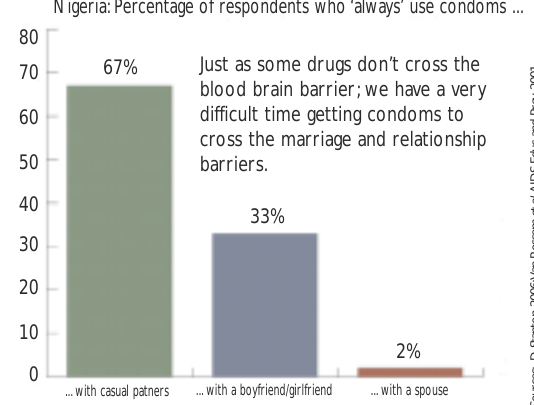
Fig. 5. Condom use in longer versus shorter-term